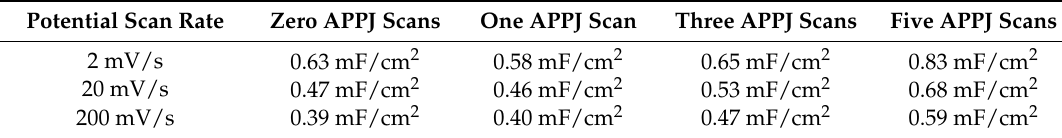
Figure 8. CV results of gel-electrolyte supercapacitors made with scan-mode APPJ processed carbon cloth (without rGO coatings): ( a ) zero APPJ scans; ( b ) one APPJ scan; (c) three APPJ scans; ( d ) five APPJ scans. Table 2. Areal capacitance of gel-electrolyte supercapacitors made with scan-mode APPJ processed carbon cloth (without rGO coatings).